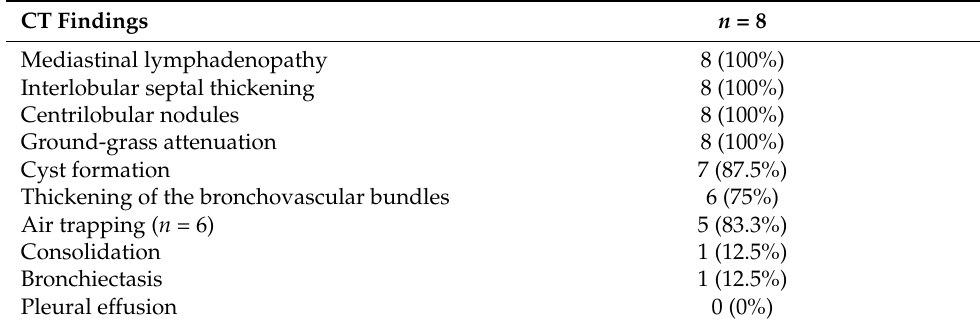
Table 2. Summary of CT findings at the first visit.